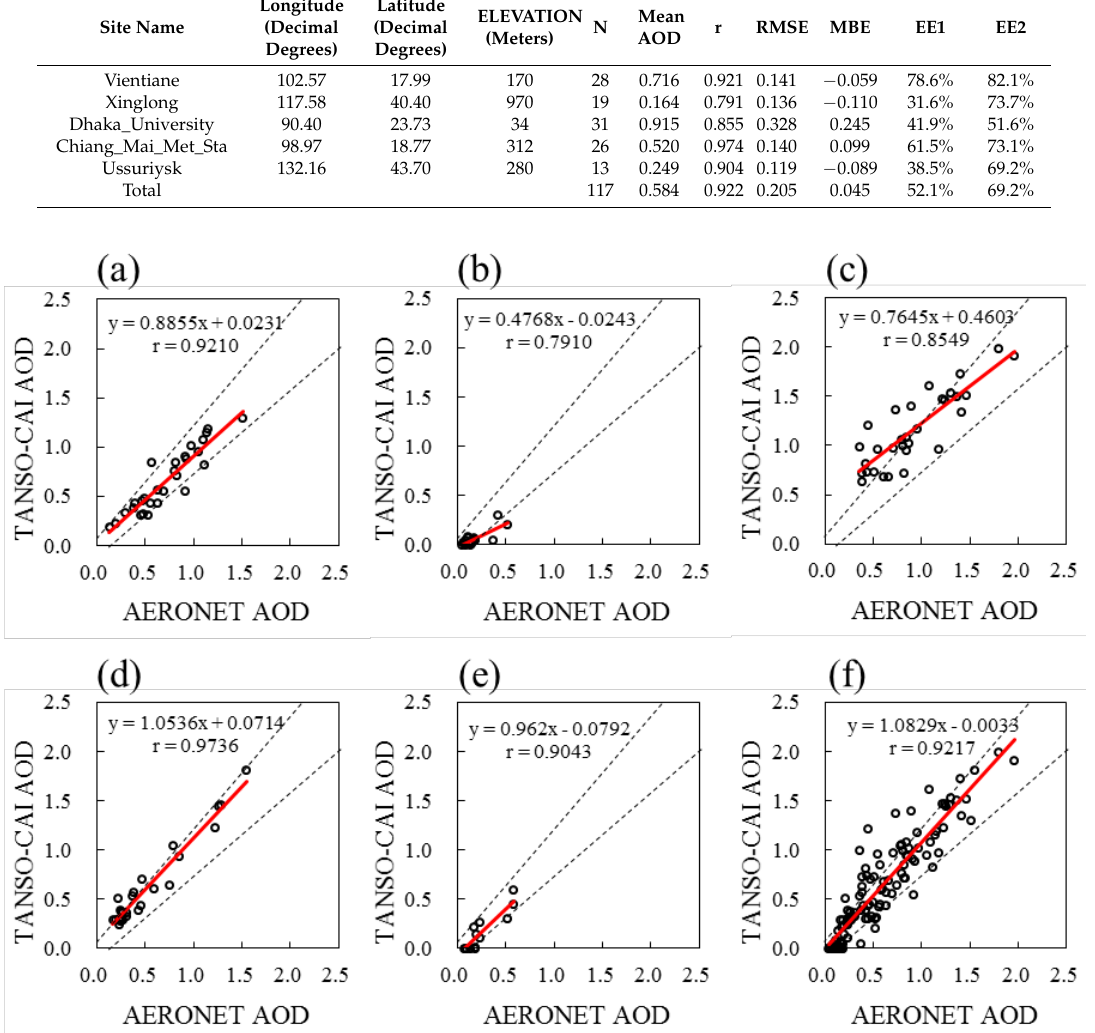
Table 4. Geographical information and summary statistics for the entire data set and each individual site: longitude, latitude, elevation, number of samples (N), correlation coefficients (r), root mean square errors (RMSE), mean bias errors (MBE), and expected errors (EE).